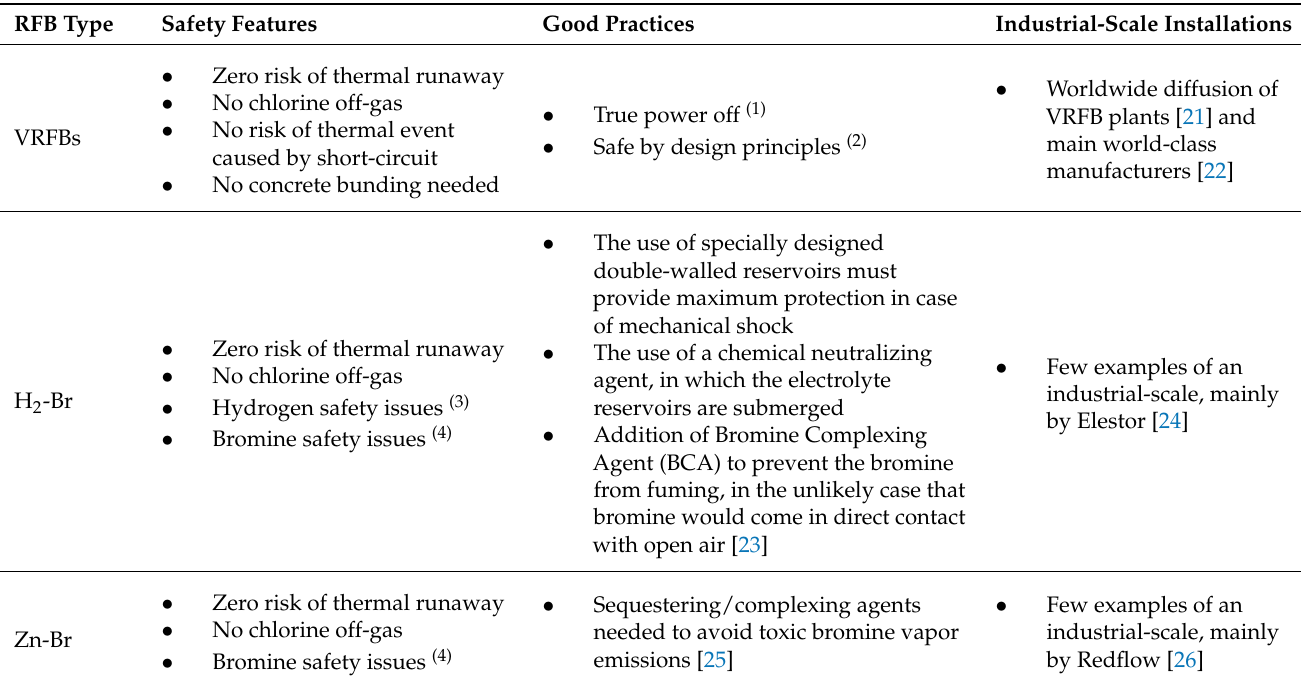
Table 2. Safety features, good practices, and examples of industrial-scale installations of VRFBs, H 2 -Br, Zn-Br